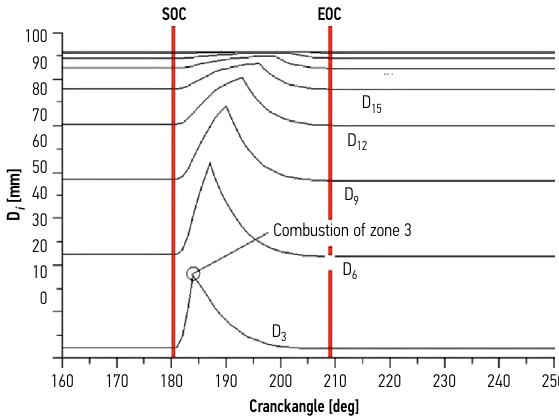
Fig. 3. The diameter of the zones in the function of the